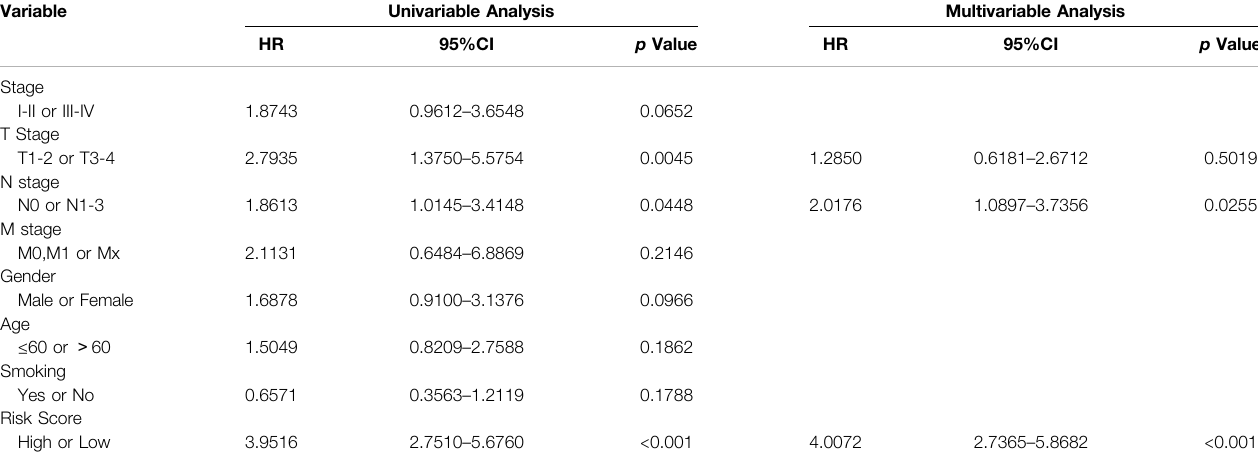
TABLE 2 | Univariable and multivariable Cox regression analysis of the PCDs-based signature and clinical feature in TCGA dataset.